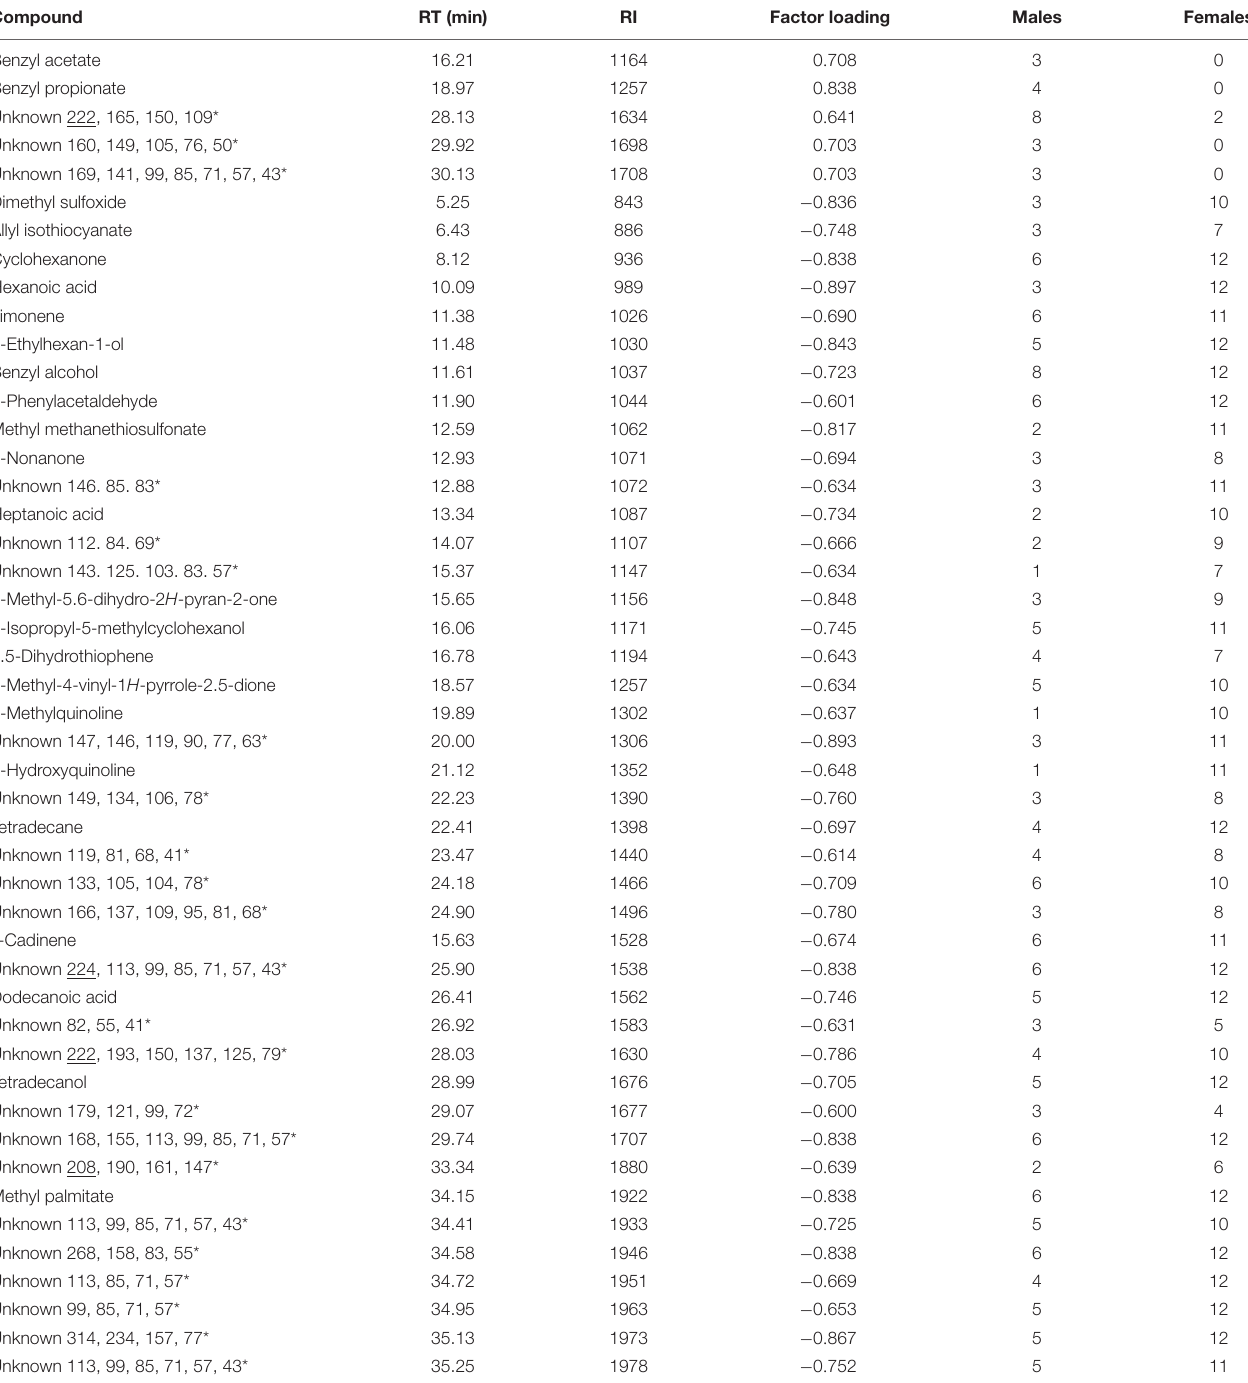
TABLE 2 | Compounds of the urine profiles of male and female mouse lemurs that contributed substantially (factor loading < -0.6 or > + 0.6 on the factor with the highest statistical contribution: Factor 1) to the discrimination of the sexes.